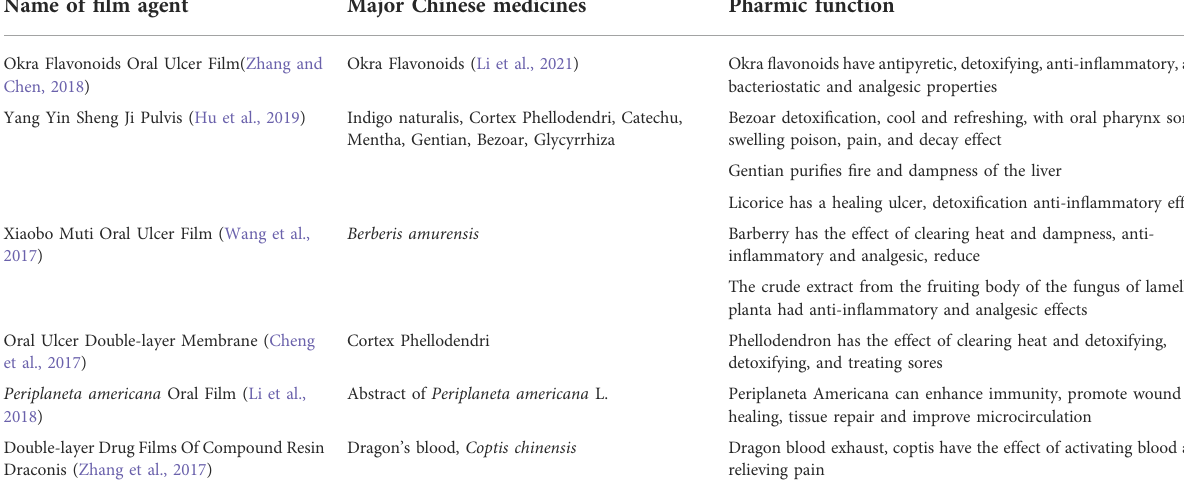
TABLE 3 Commonly used oral ulcer patch formula and pharmacological